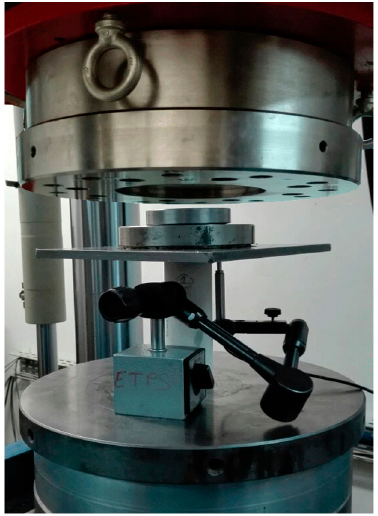
Figure 6. Compression test setup used with the Schenck press in 3SR lab.